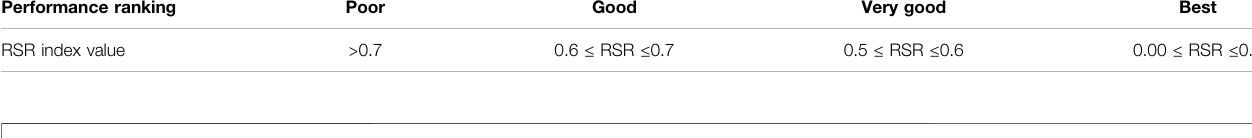
Frontiers in Earth Science |